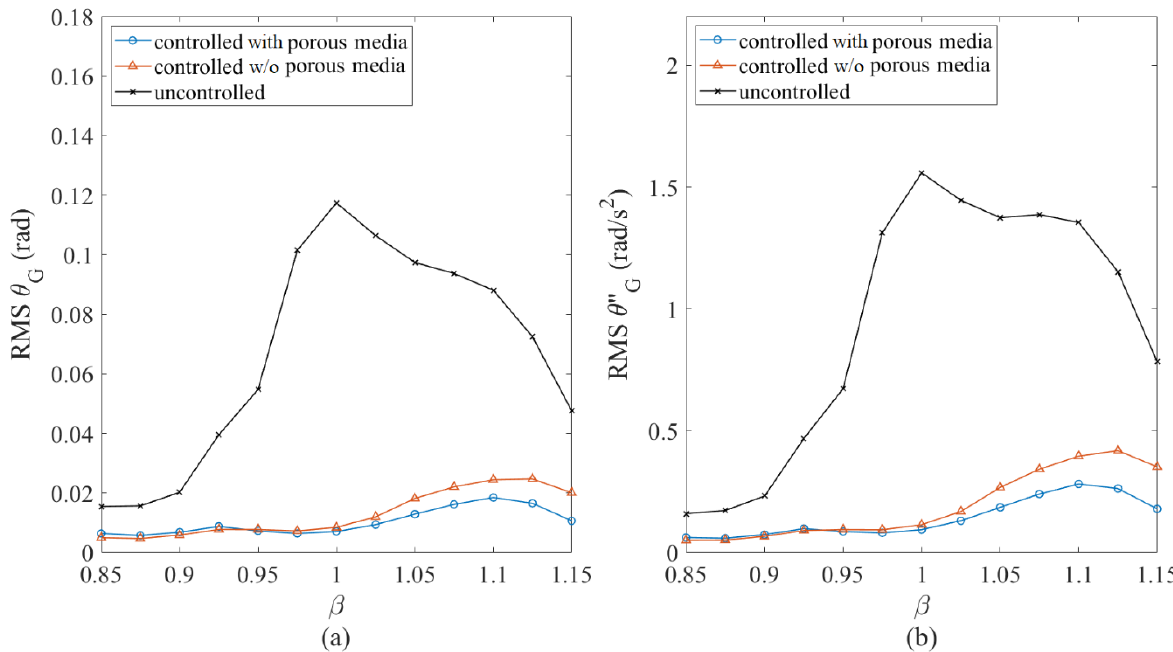
Figure 34. The frequency responses of the RMS responses of the controlled and uncontrolled floating bodies for the small-wave case: ( a ) angular displacement; ( b ) angular acceleration.